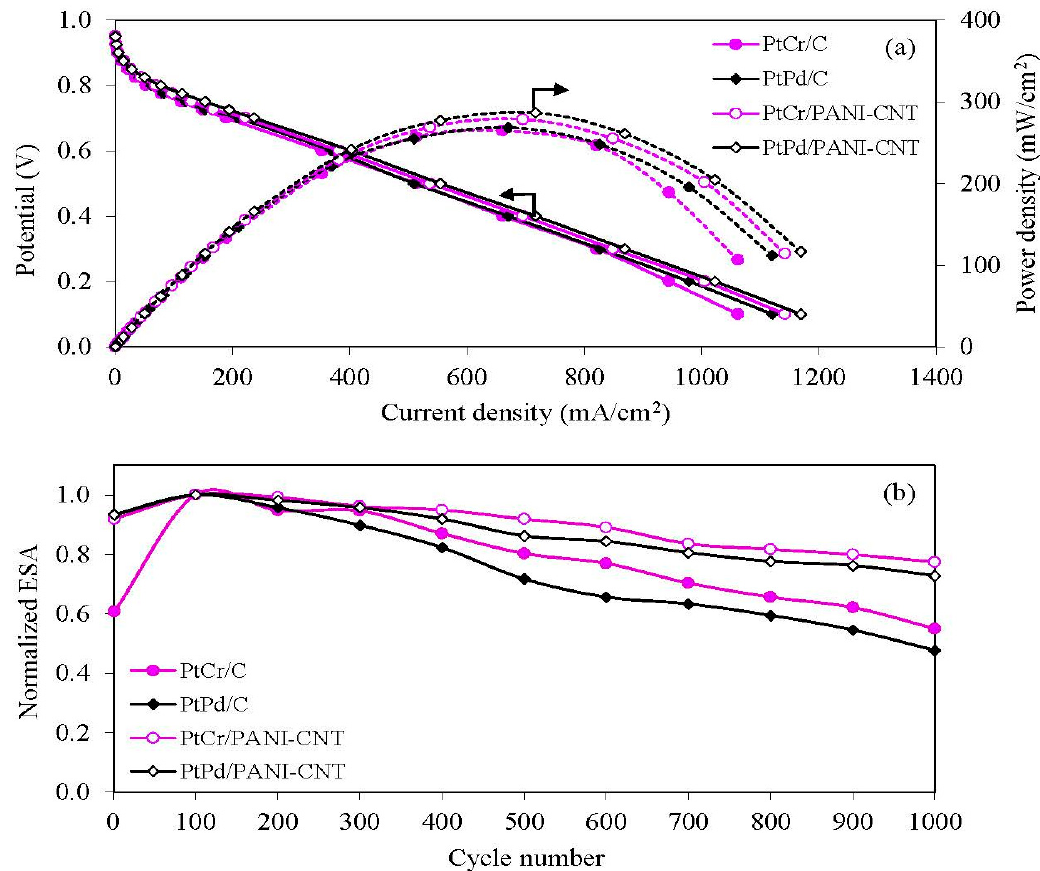
Figure 10. Representative of comparative: ( a ) performance in PEM fuel cell; and ( b ) stability in 0.5 M H 2 SO 4 of the different catalysts.